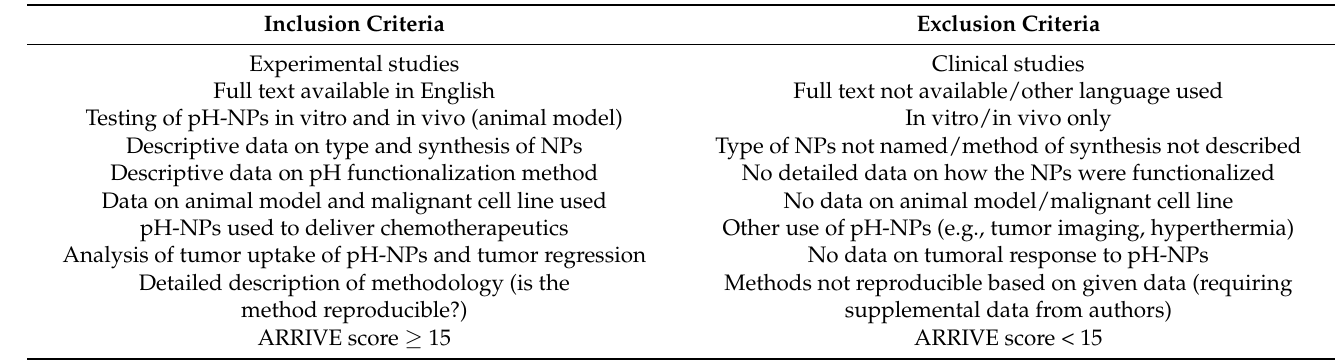
Table 1. Overview of inclusion and exclusion